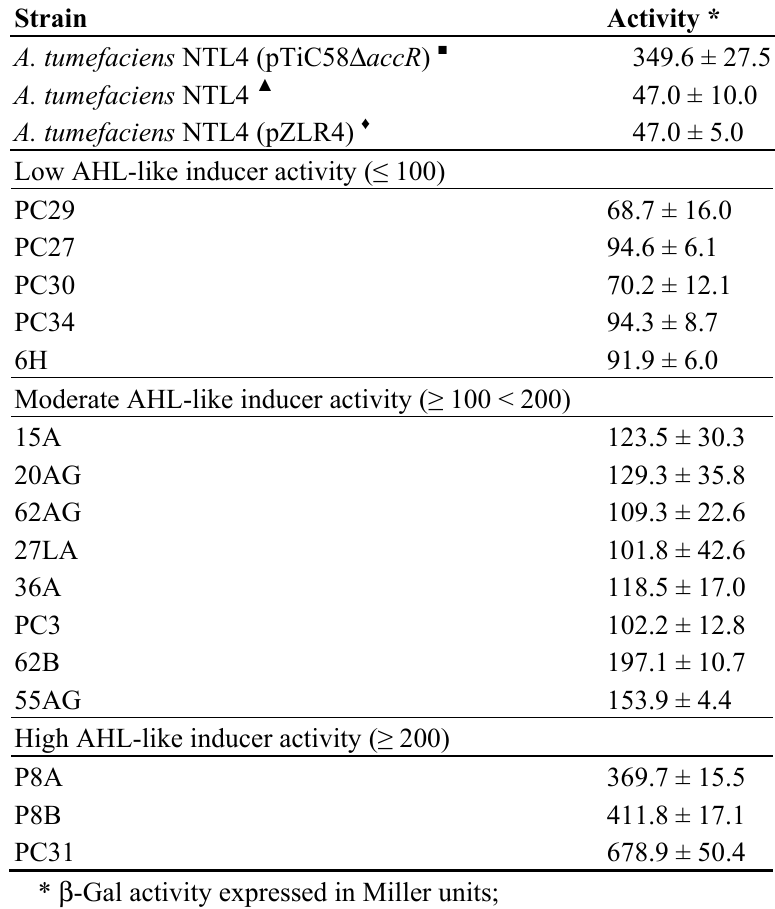
Table A2. Induction of β -galactosidase activity in A. tumefaciens NTL4 (pZLR4) by AHLs obtained from supernatants of peanut-nodulating rhizobial